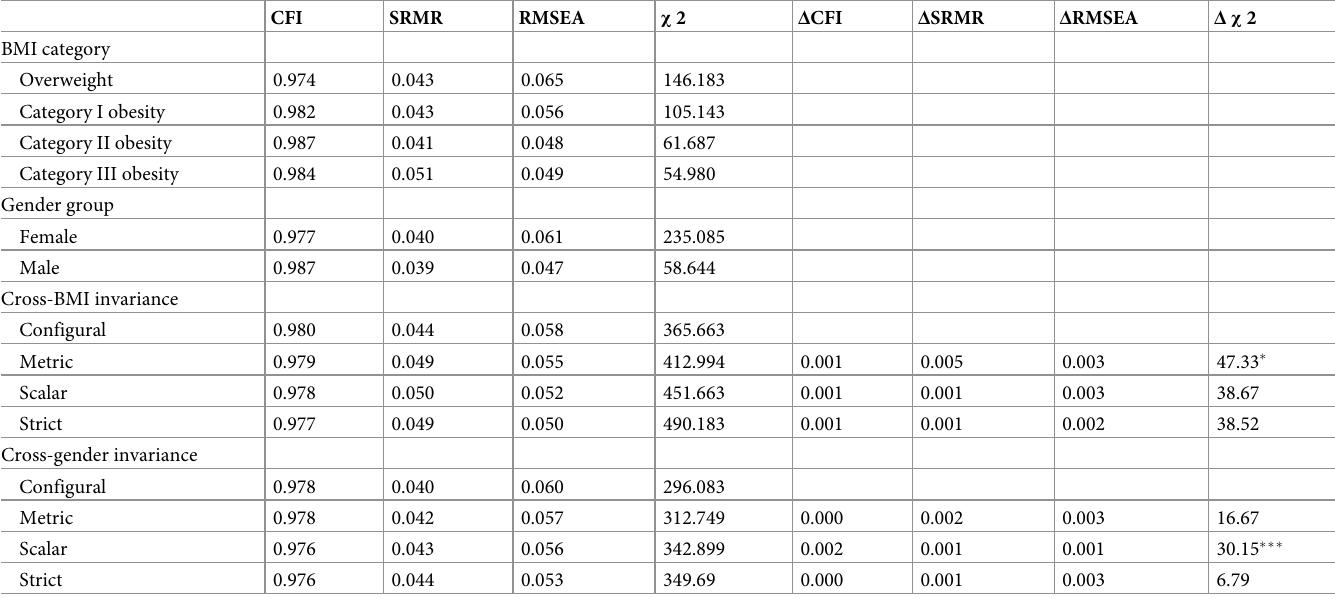
Table 9. Goodness of fit indices of models testing for Cross-BMI and Cross-gender invariance in study